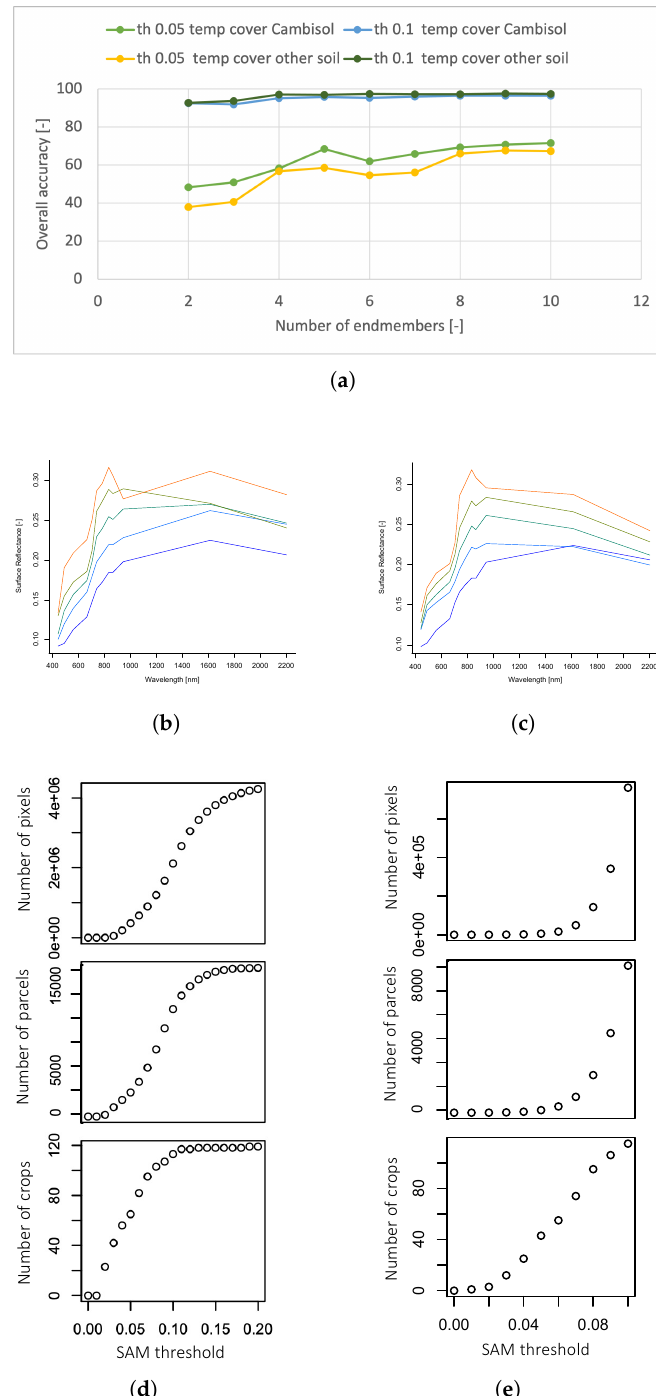
Figure 12. The spectra of selected end-members and the commissioned pixels, parcels, and crop type per threshold for detecting temporary covered pixels in the dataset acquired on 20 April 2020—Rank 1. ( a ) The accuracy plot of reference spectra for end-members scenarios and SAM thresholds (th) of 0.05 and 0.1. ( b ) Five end-members for covered Cambisols. ( c ) Five end-members for other covered soil groups. ( d ) Commissioned features for Cambisols. ( e ) Commissioned features for other soil